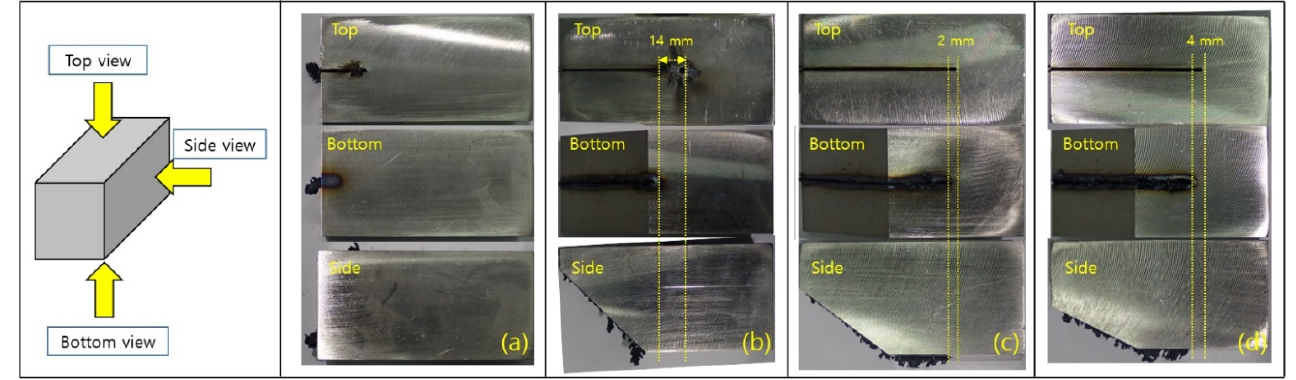
Figure 3. Cut specimen images: ( a ) case 1, ( b ) case 2, ( c ) case 3, and ( d ) case 4.